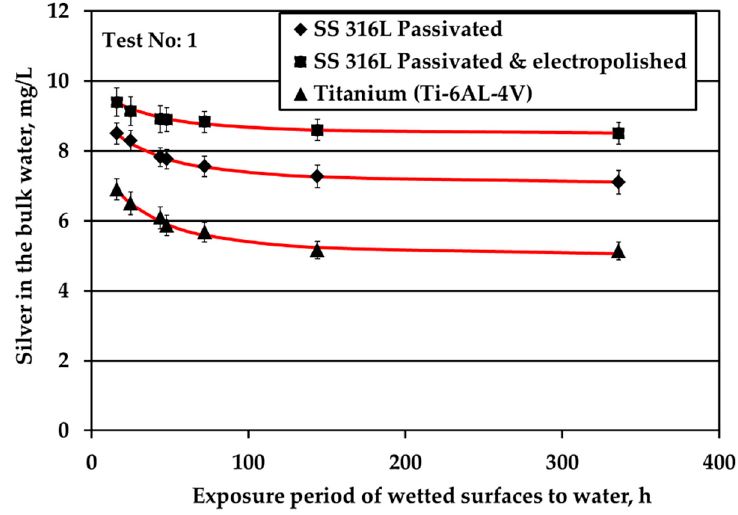
Figure 5. Experimental data of silver loss (obtained during test with S/V = 1.0 cm − 1 and Ag concentration = 10 mg/L in the absence of water motion) along with fitting curves.